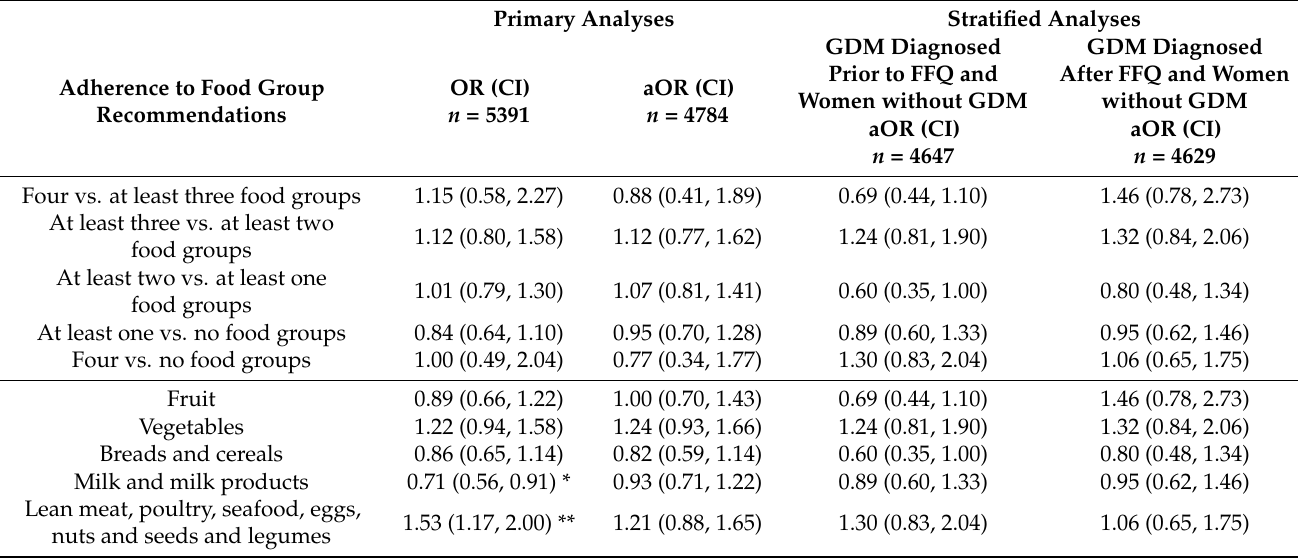
Table 3. Unadjusted and adjusted odds of having GDM according to adherence Ministry of Health food group